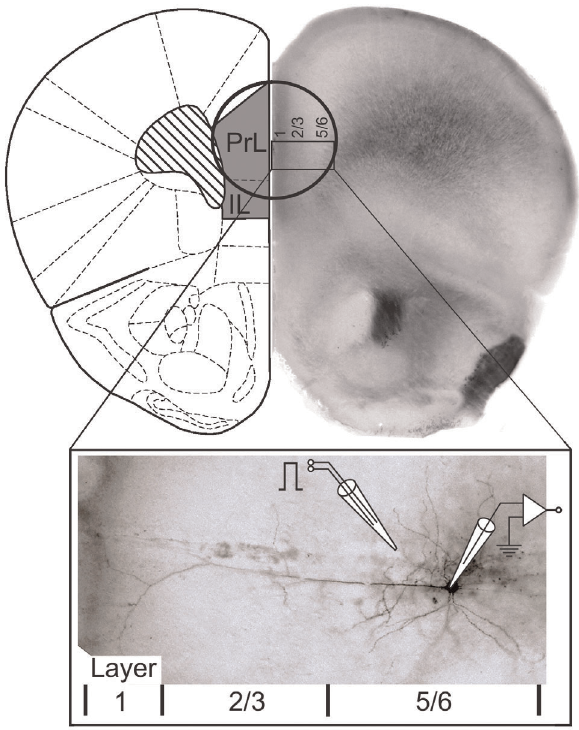
Figure 1. Schematic of the prefrontal cortex (PFC) demonstrat- ing location of tissue punches and neurons used for electro- physiology experiments and morphological analysis. Top: Tissue punches used for western blot analysis centered on the prelimbic (PrL) PFC. Shown are sections of the mouse brain at Bregma 2.00 mm. Bottom : The box shows a bright-field image of a biocytin-labeled layer V pyramidal neuron in the PrL PFC. The inserts show a typical arrangement of the recording and theta-glass stimulation electrode, which was placed within the same layer as the recorded neuron near the basal